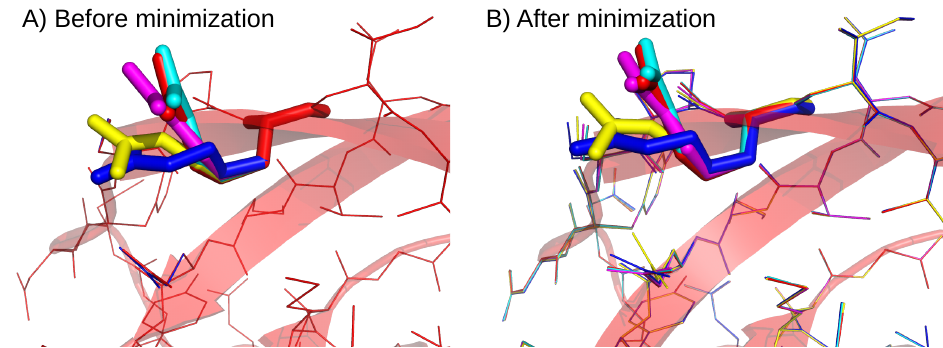
Figure A1. Illustration of the different rotamers for the arginine in position 45. Superimposition of the five structures of the K45R mutant before ( A ) and after the minimization process ( B ). Mutant structures are presented in line and cartoon mode. Residues R45 are presented in sticks.